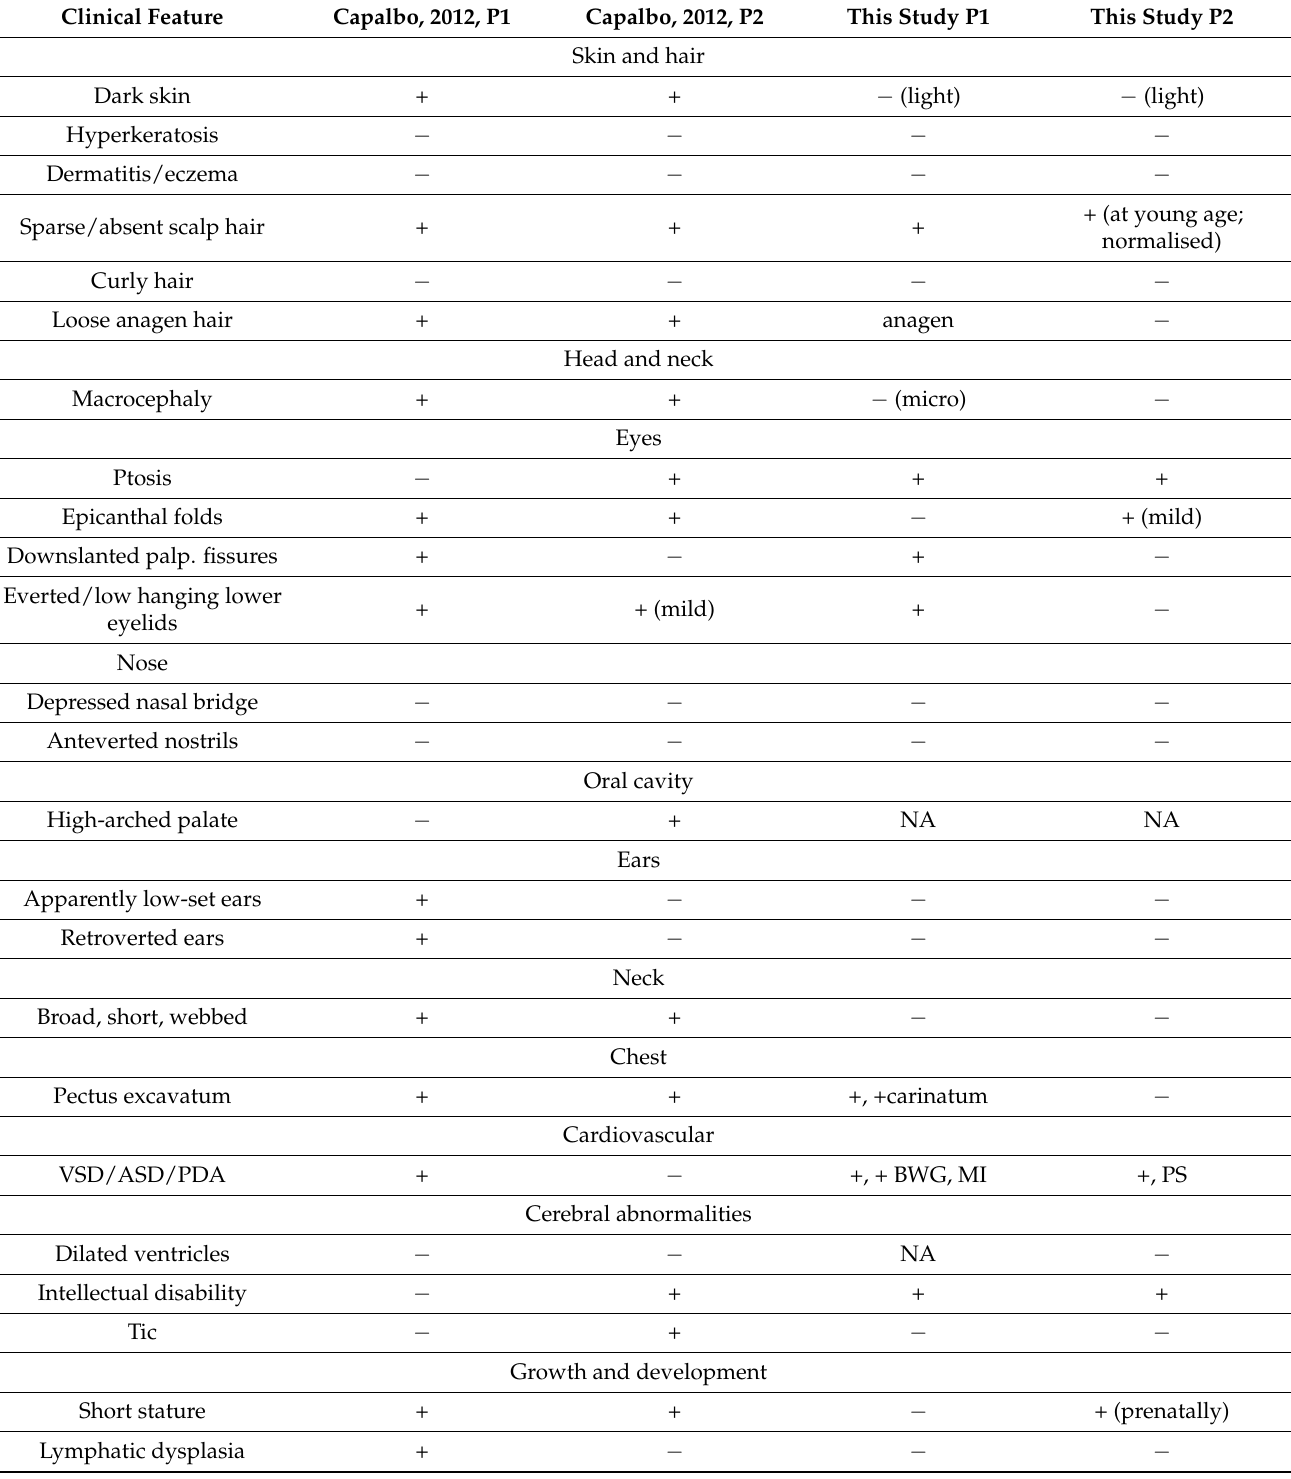
Table 2. Comparison of findings in current patients to the patients of Capalbo et al., 2012. Clinical